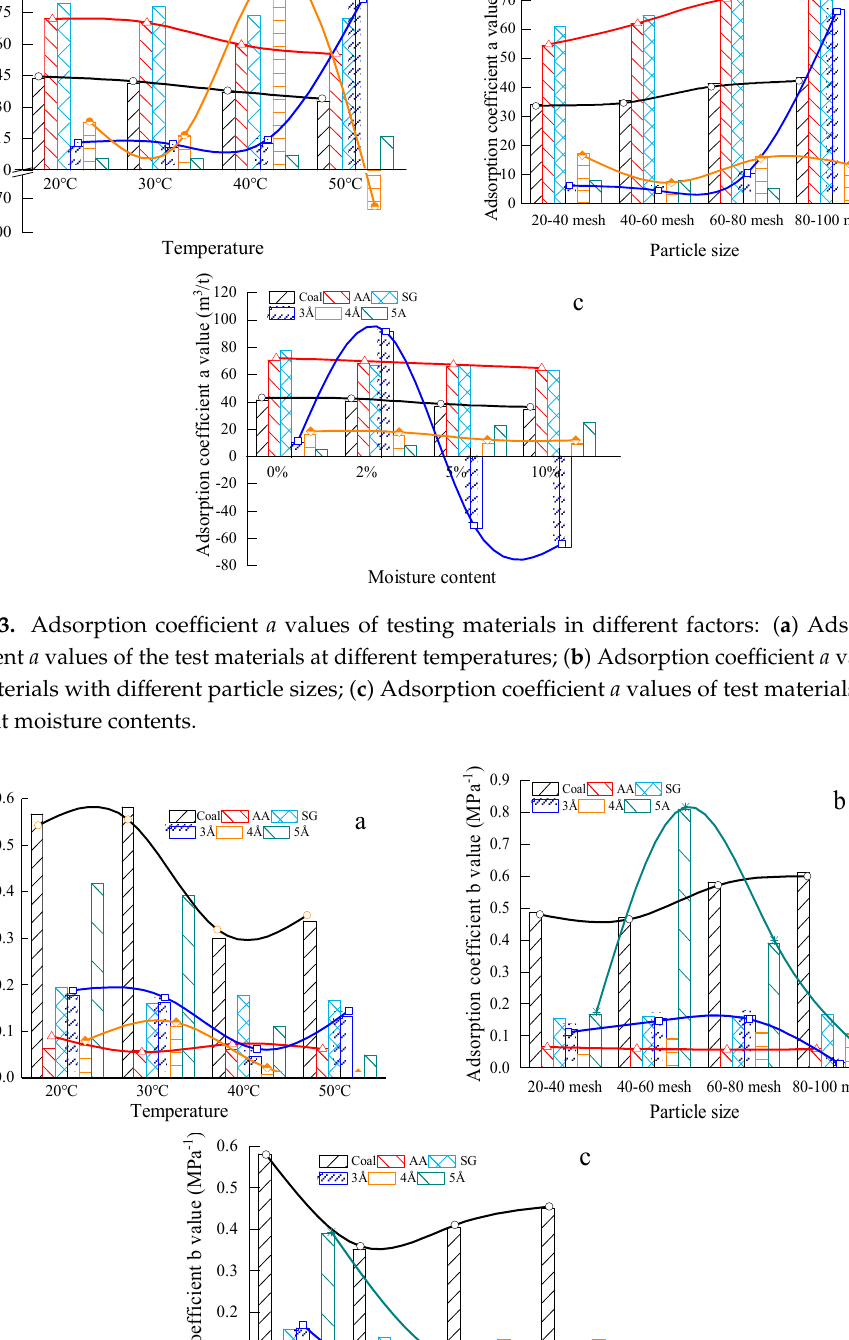
Figure 4. Adsorption coe ffi cient b values of testing materials in di ff erent factors: ( a ) Adsorption